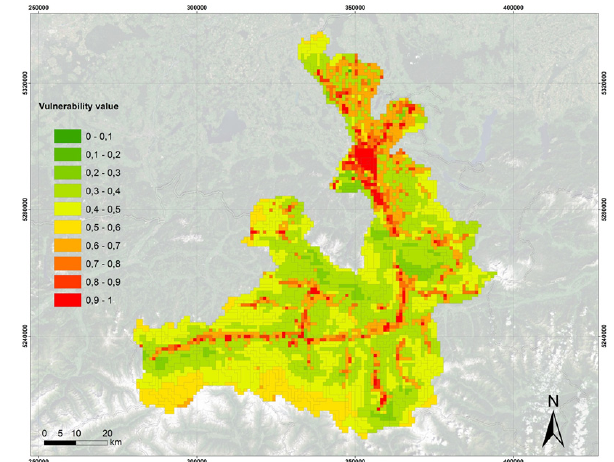
Figure 7. Bhutan case study: Climate change impacts on agri- cultural calendar / socioeconomic development (shift in precipita- tion / weather patterns) – by Gewog.